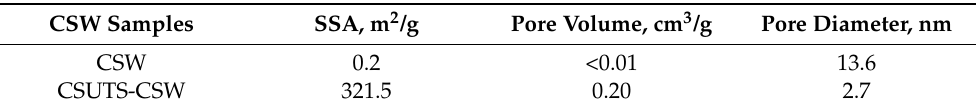
Figure 2. FT-IR ( A ) and XRD ( B ) analysis of CSW ( a ) and CSUTS-CSW ( b ). Table 1. Characterization of CSW and CSUTS-CSW a .